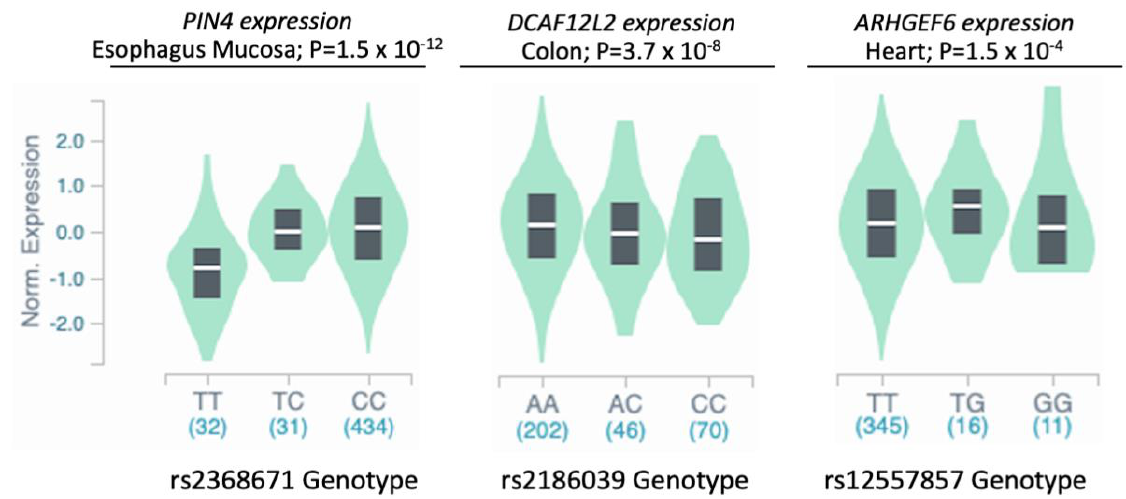
Figure 4. Gene expression in relation to genotypes of ASD-associated SNPs. Bean plots of normalized gene expression in relation to genotypes showing the median (white line) and interquartile range (black box). Data and plots were adapted from the GTEx database [48].